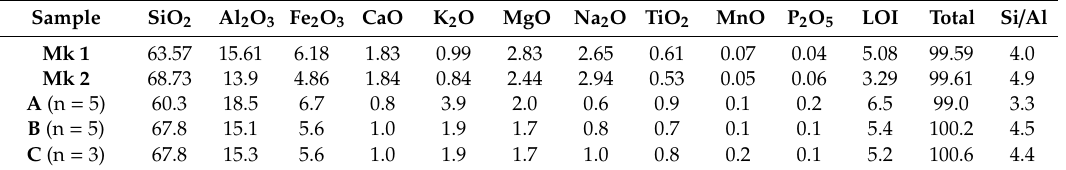
Table 3. Chemical composition (%) of Mokundeni clays versus brick clays from Italy.